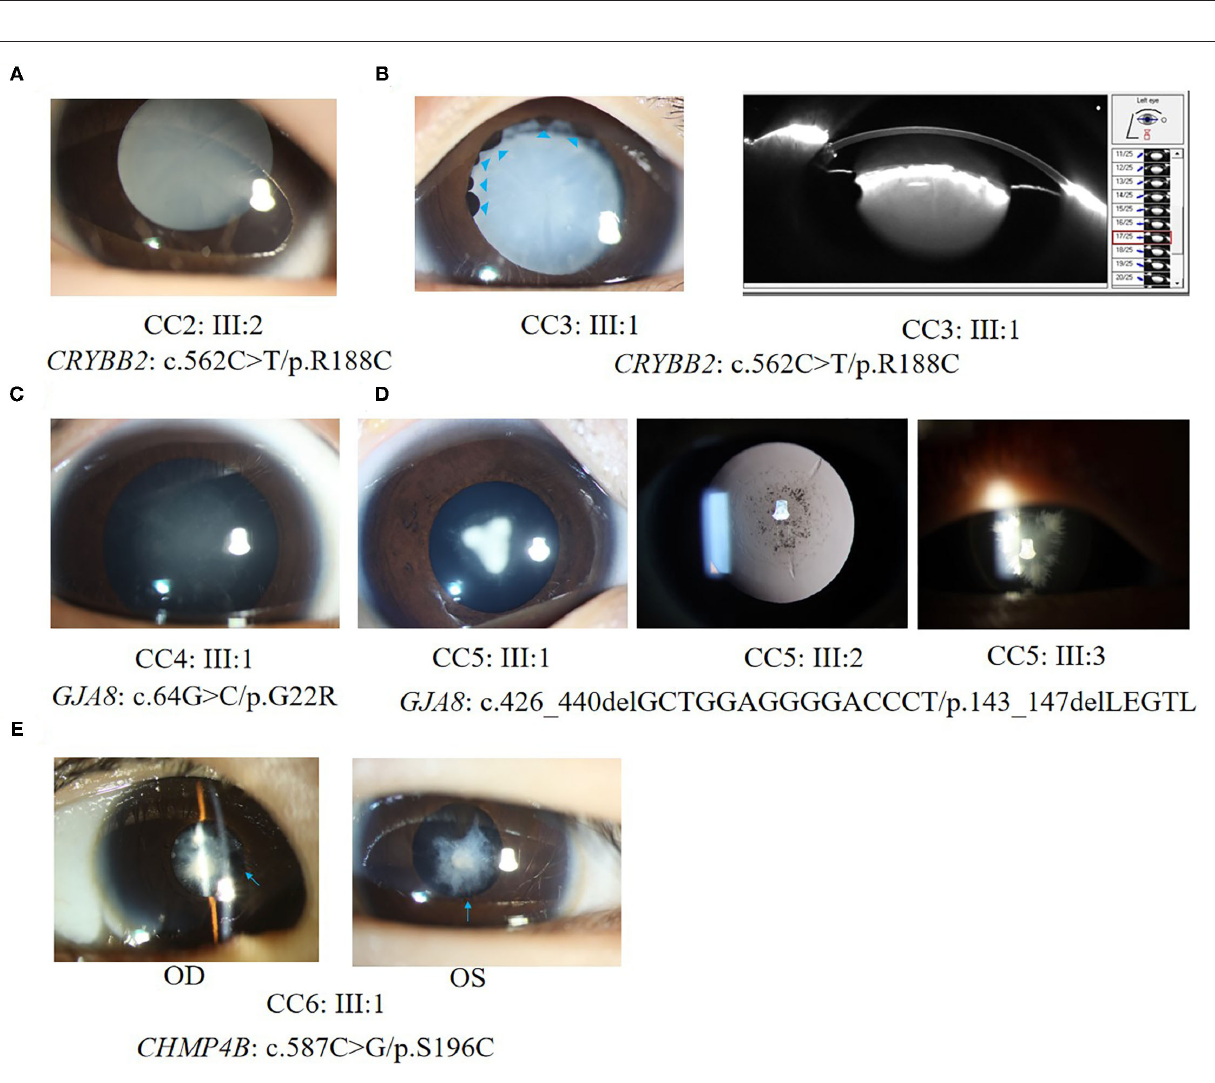
FIGURE 3 | Ocular phenotypes of patients with CCs. (A) The total cataract of III:2 in family CC2; (B) Left panel: the total cataract and primary iris cysts (blue arrowheads) of III:1 in family CC3; Right panel: the anterior segment image from Pentacam shows the 3 o’clock and 9 o’clock section of cataracts and iris cysts of III:1 in family CC3. (C) The fetal nuclear opacities with fuzzy Y-sutural opacity of III:1 in family CC4. (D) The Y-sutural and axial embryonal nuclear cataracts with different appearances of III:1, III:2, and III:3 in family CC5. (E) The anterior subcapsular cataracts and posterior synechia of iris (blue arrows) of III:1 in family CC6.